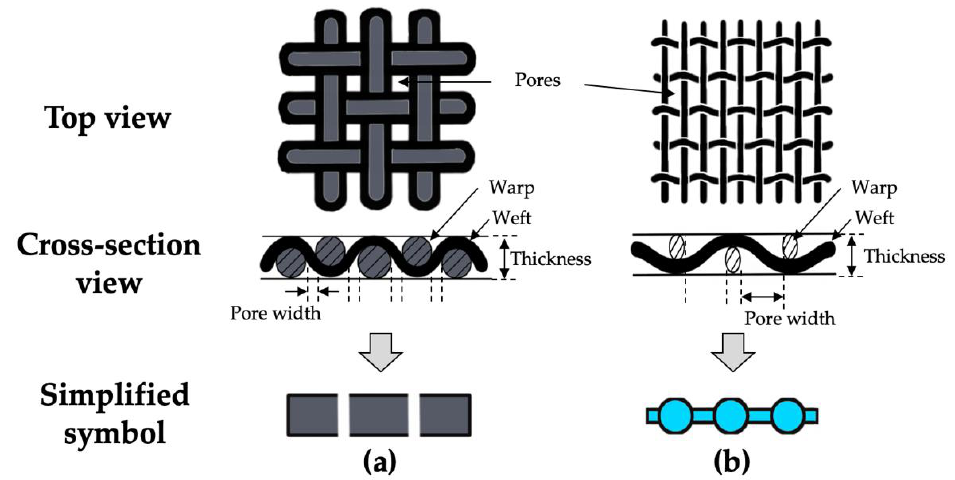
Figure 3. Schematics of the top view, cross-section view, and simplified symbol: ( a ) woven fabric; ( b ) mesh.